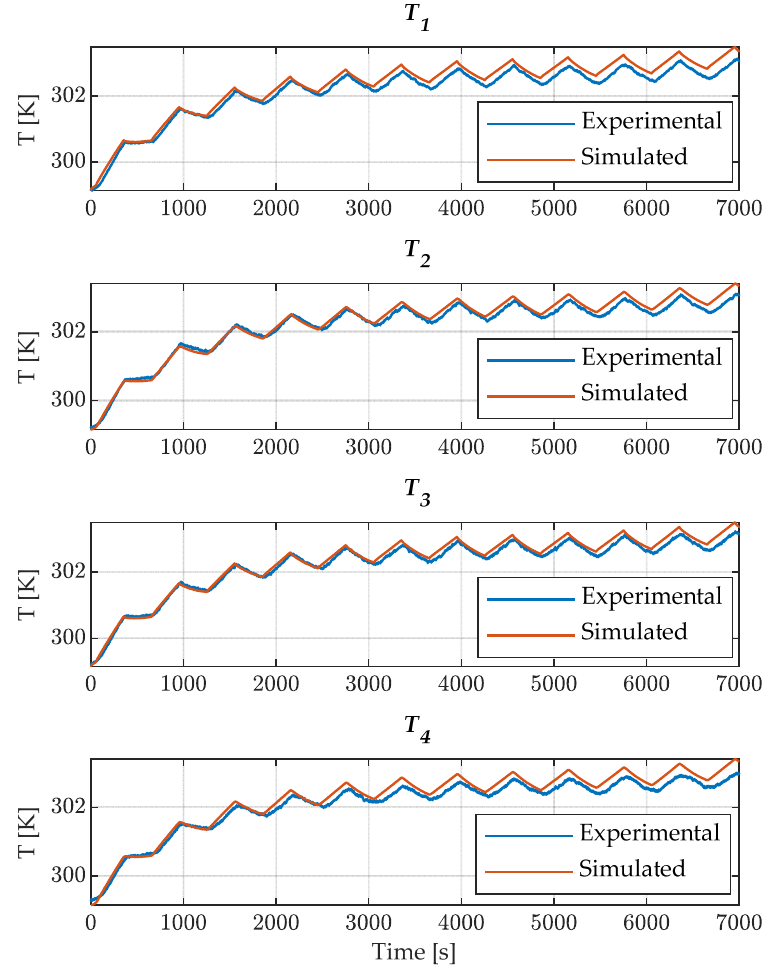
Figure 11. Thermocouples results for the single cell test at 10 A.